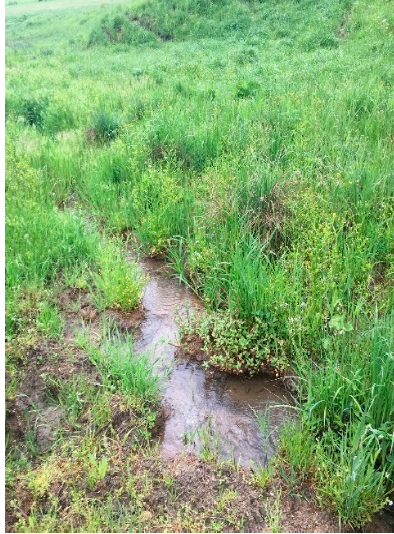
Figure 10. Laslea River non-refuge sector.